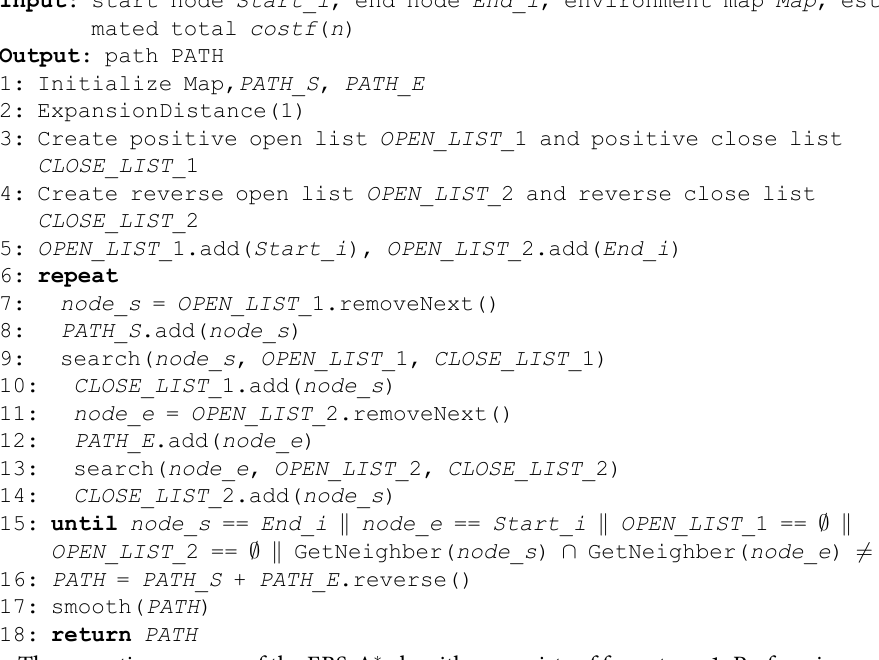
Algorithm 1 The code of the EBS-A �